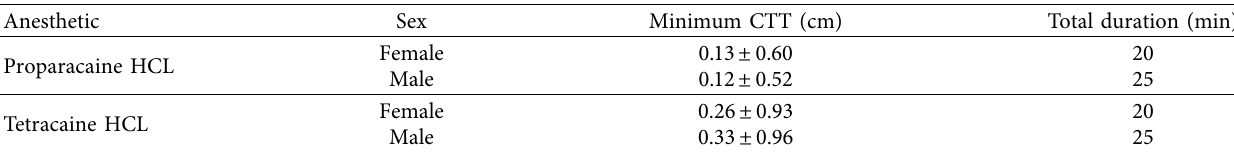
Table 2: Minimum CTT values and total duration of effect with respect to